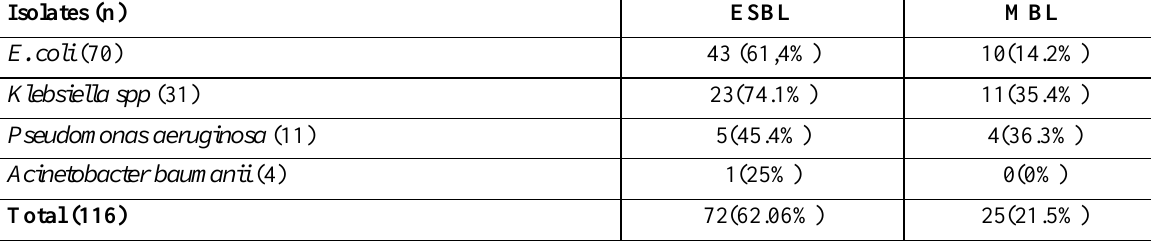
Table 3. Fosfomycin effect on various beta-lactam resistant isolates.